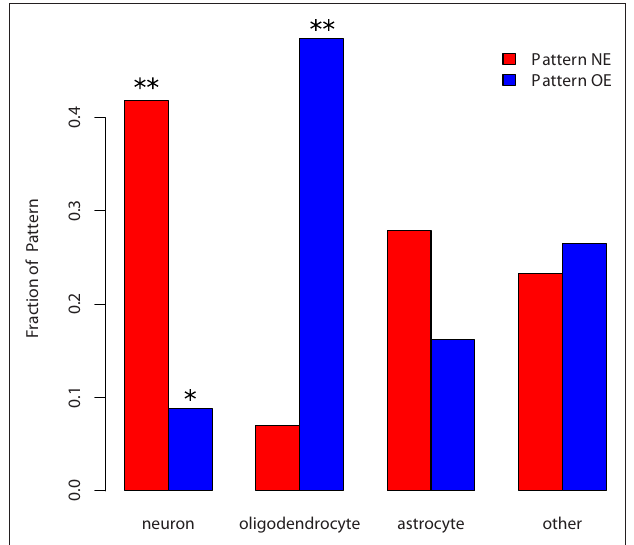
Figure 4 | Fraction of cell-type enriched genes appearing in the two patterns. p -values below 0.05 are marked by * and below 0.005 with **. Neuron-enriched genes are overrepresented in the NE list and underrepresented in the OE list. Oligodendrocyte genes are overrepresented in the OE list but not significantly underrepresented in the NE list.